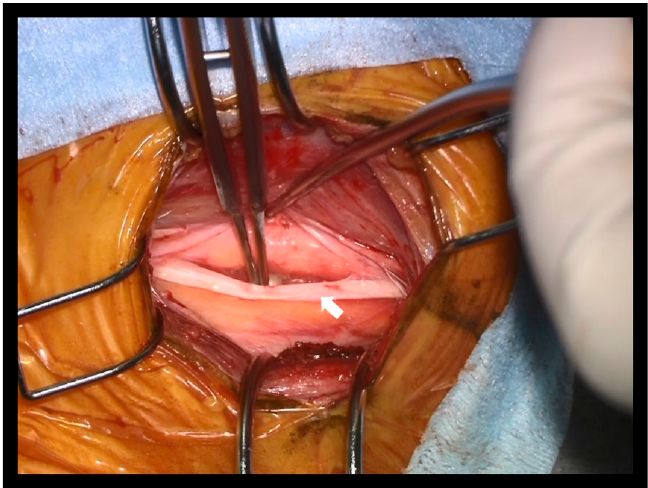
Figure 4. The intraoperative picture in case 1. The vagus nerve was detected by laterally pulling the IJV as the authors preoperatively predicted (allow). The white arrow indicates the vagus